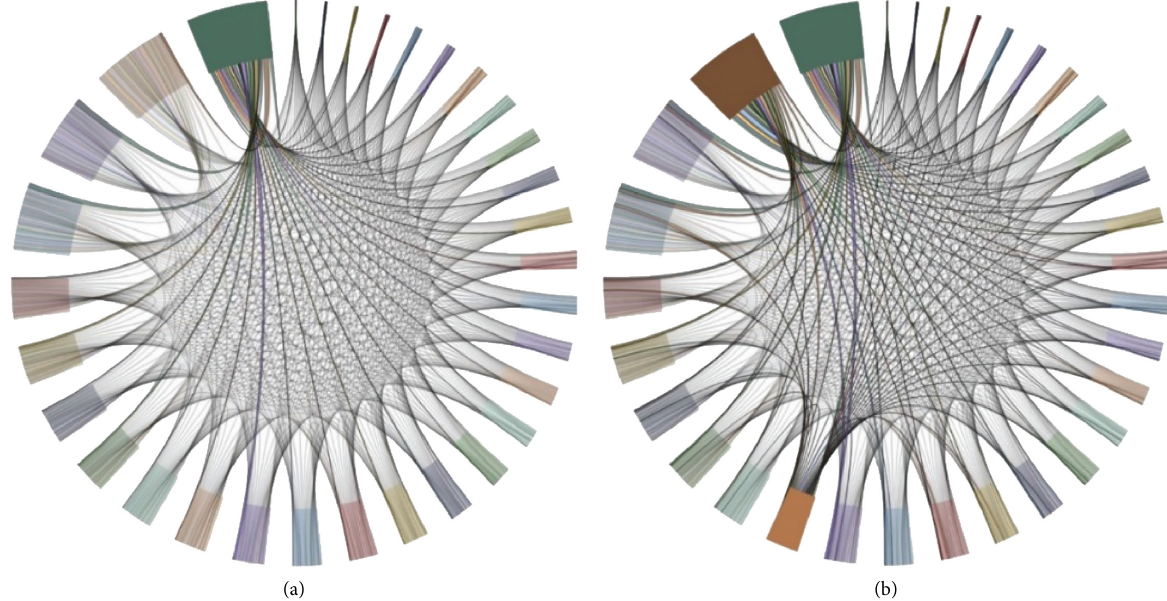
Figure 24: Chord chart of commodity flow. (a) Chord diagram of commodity flow in a single region. (b) Chord diagram of commodity flow in multiple regions.